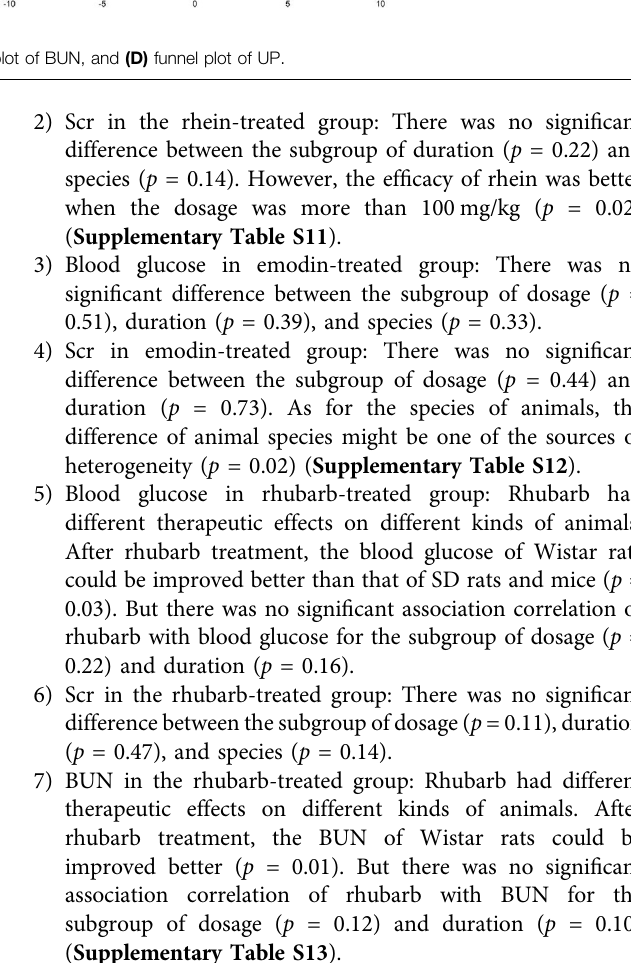
Frontiers in Pharmacology |